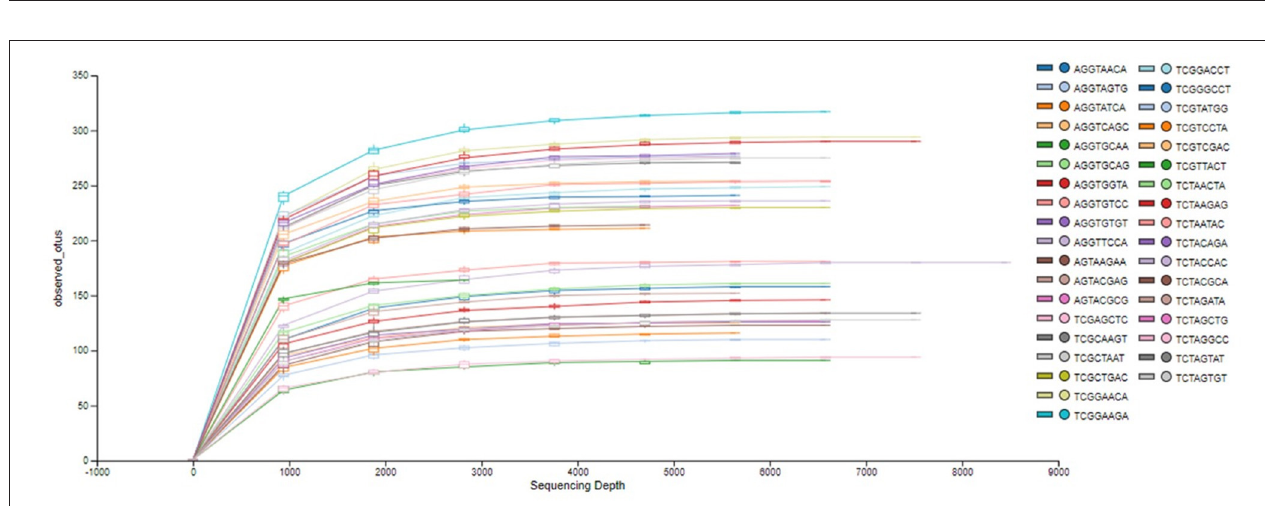
FIGURE 1 | Schematic illustration by BioRender ® of the relevant anatomy of the rumen: lateral view. The star icon indicates the location of where samples were collected via rumen cannula.